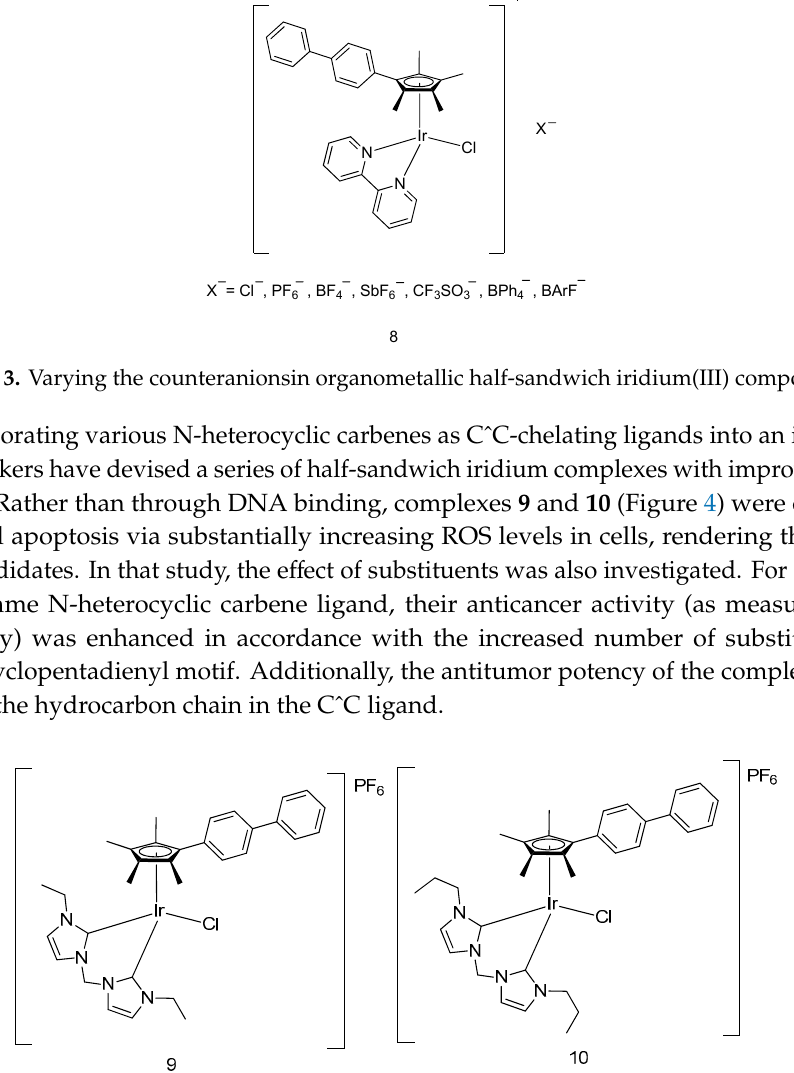
Figure 4 . Organometallic half-sandwich iridium(III) compounds with N-heterocyclic carbene groups.